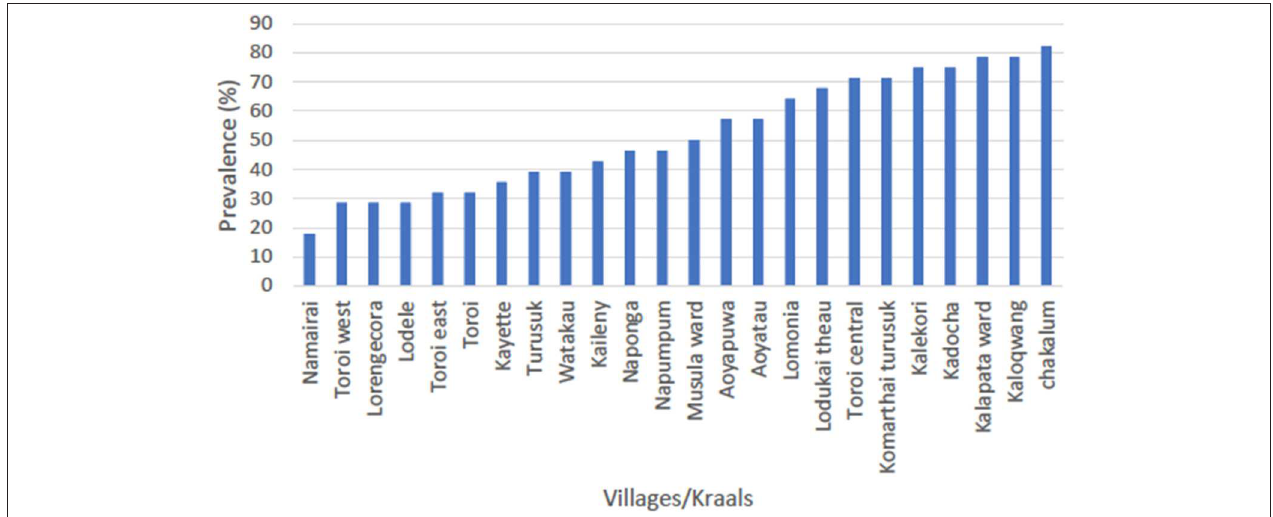
FIGURE 4 | Serosurvey result for the northern focus of transmission (Kotido-Kaabong). The average prevalence in the northern focus was 51.4% with the highest seroprevalence being 82.1% in Chakalum village whereas the lowest was 17.9% in